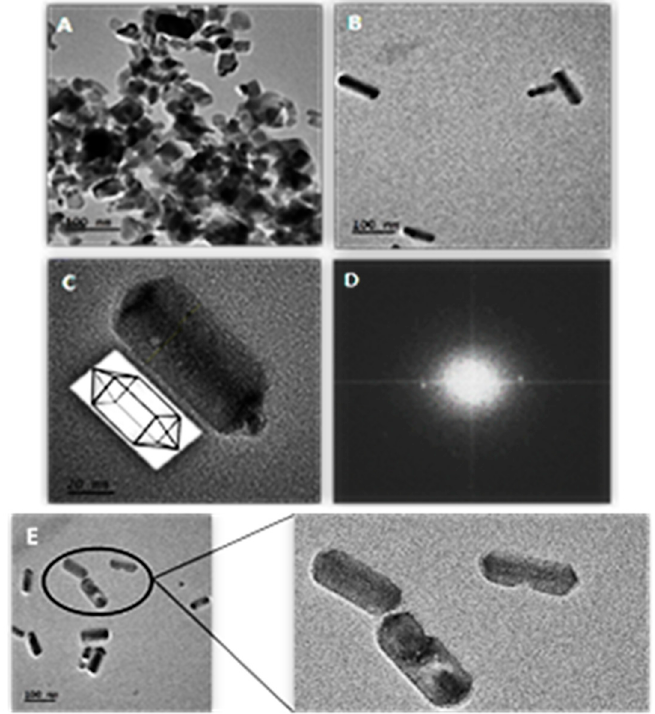
Figure 1. Transmission electron microscopic (TEM) images of ( A ) uncoated IONR exhibiting sig- nificant agglomeration, ( B ) mono disperse BPEI-coated IONRs, ( C ) single IONR with tetragonal prism-dipyramid morphology, ( D ) Fast Fourier Transformation (FFT) crystal structure diffraction pattern of BPEI-IONRs, ( E ) uniformity in size, shape, and the polymer coating of